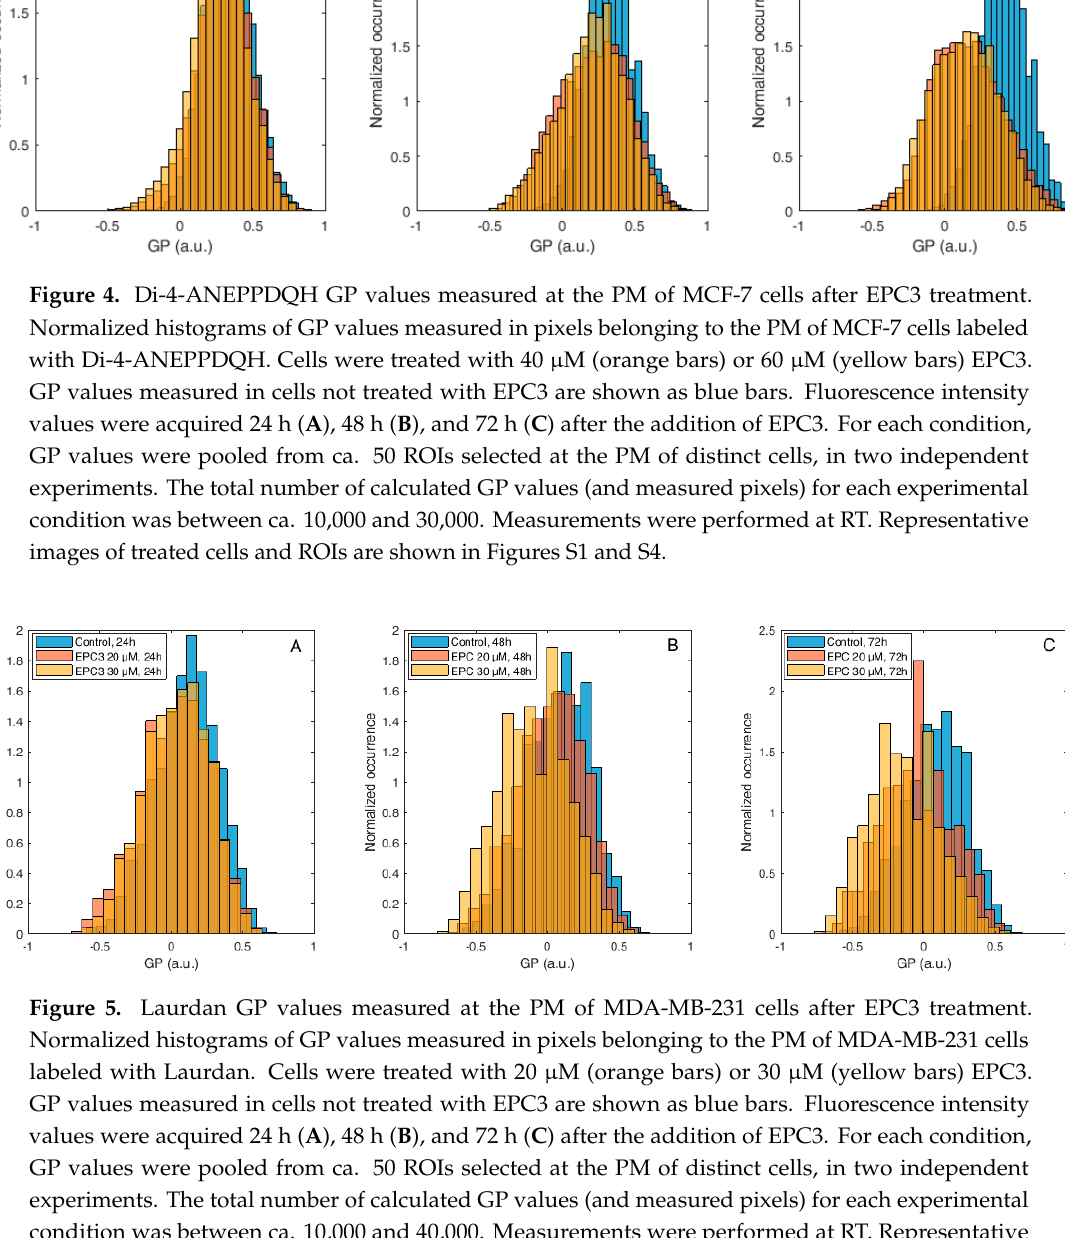
Figure 4. Di-4-ANEPPDQH GP values measured at the PM of MCF-7 cells after EPC3 treatment. Normalized histograms of GP values measured in pixels belonging to the PM of MCF-7 cells labeled with Di-4-ANEPPDQH. Cells were treated with 40 µM (orange bars) or 60 µM (yellow bars) EPC3. GP values measured in cells not treated with EPC3 are shown as blue bars. Fluorescence intensity values were acquired 24 h ( A ), 48 h ( B ), and 72 h ( C ) after the addition of EPC3. For each condition, GP values were pooled from ca. 50 ROIs selected at the PM of distinct cells, in two independent experiments. The total number of calculated GP values (and measured pixels) for each experimental condition was between ca. 10,000 and 30,000. Measurements were performed at RT. Representative images of treated cells and ROIs are shown in Figures S1,S4.